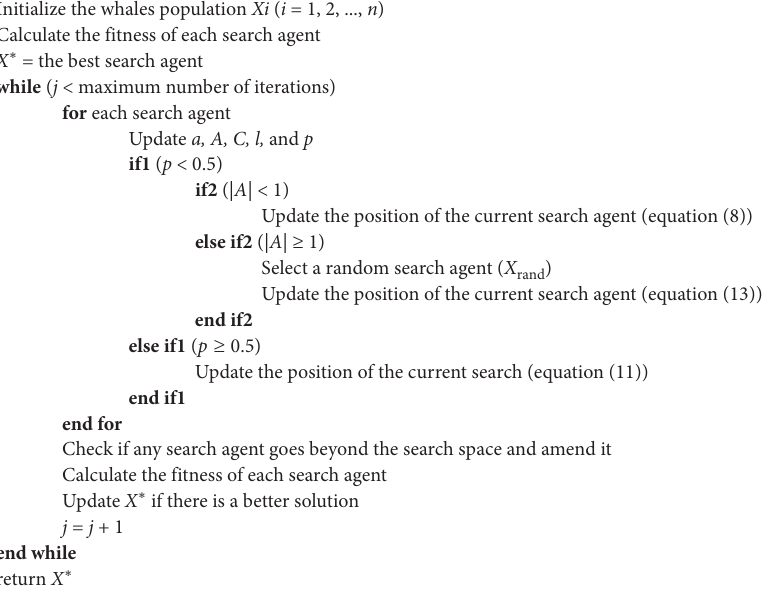
Figure 5: Pseudocode of the WOA, adapted from Mirjalili and Lewis [49].